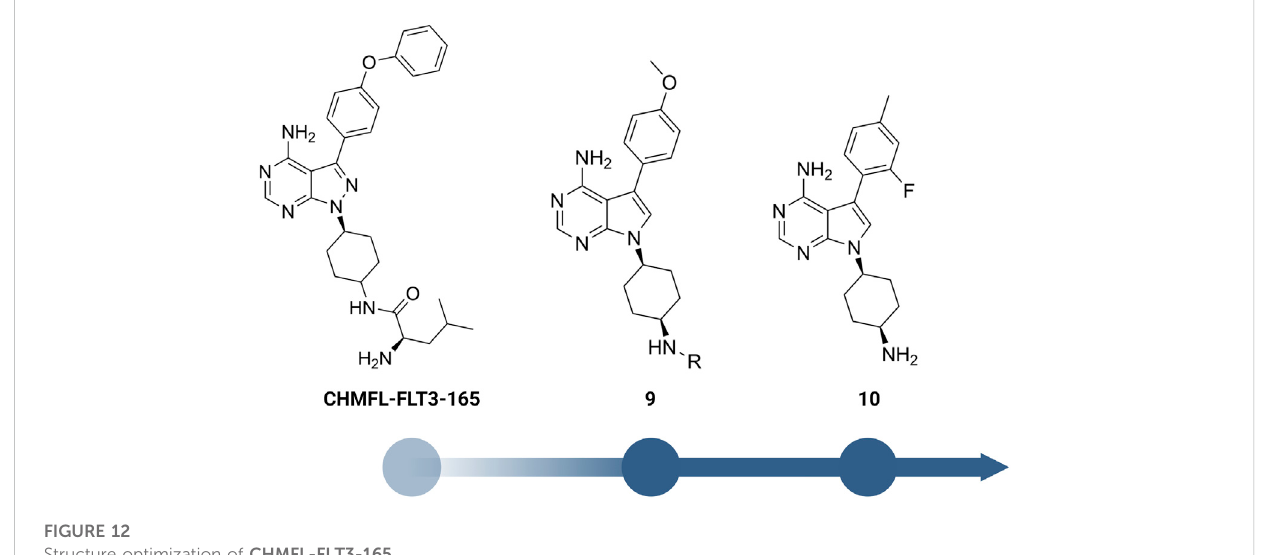
Structure optimization of CHMFL-FLT3-165